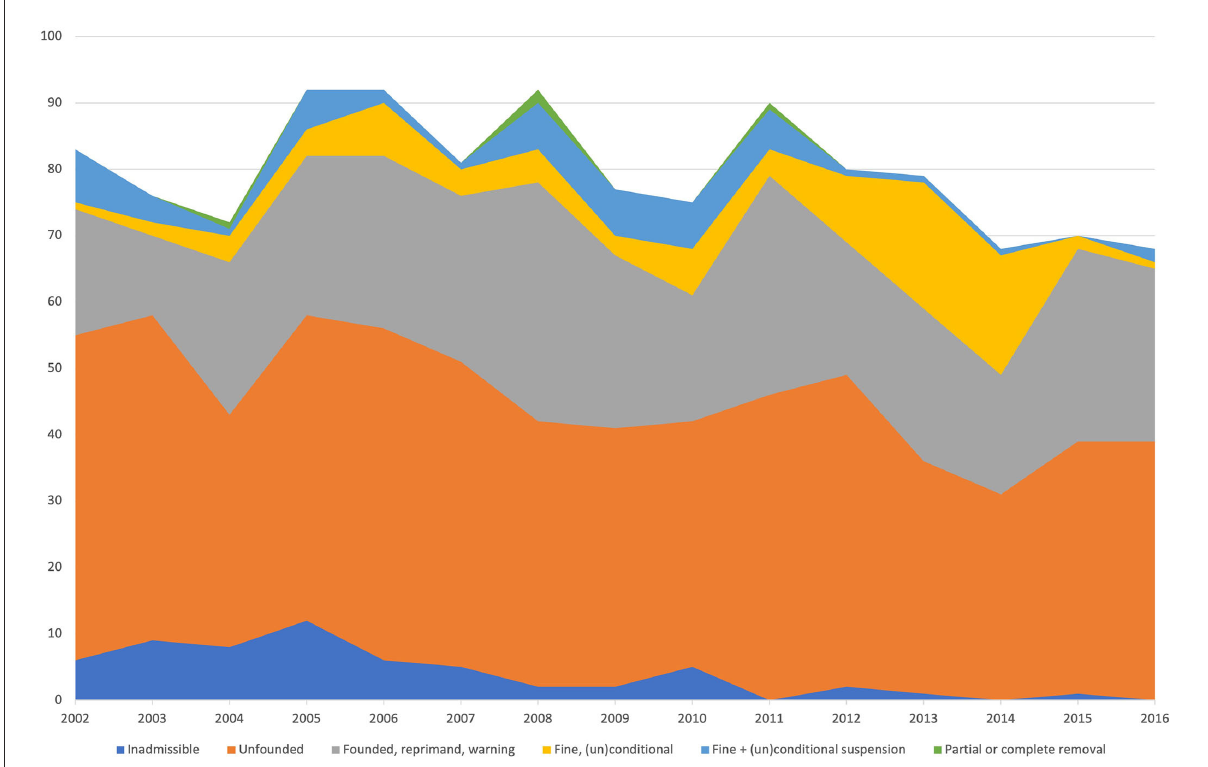
FIGURE1 Rulings of the VCD for all cases filed from 2002 to 2016. The color corresponds with the ruling of the veterinary disciplinary council